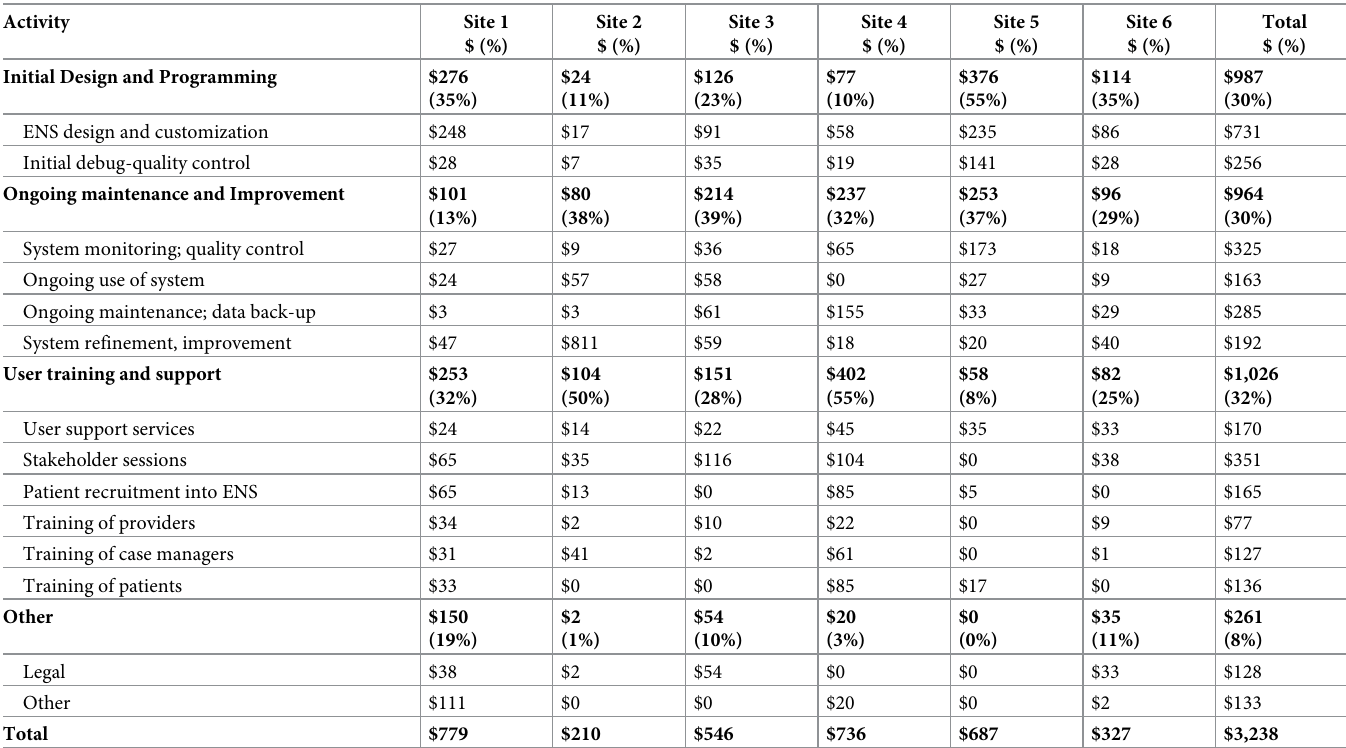
Table 2. Distribution of personnel costs by activity and site (costs in thousands).